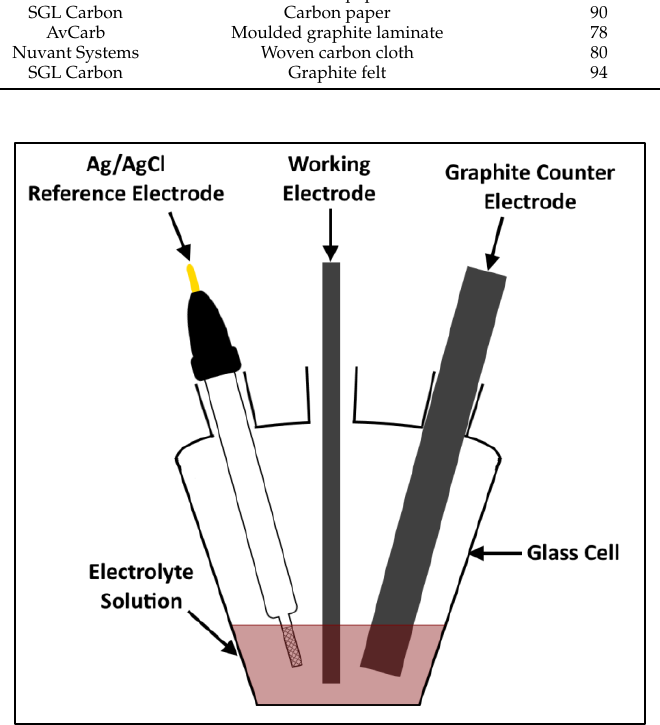
Figure 1. Schematic of the three-electrode half-cell